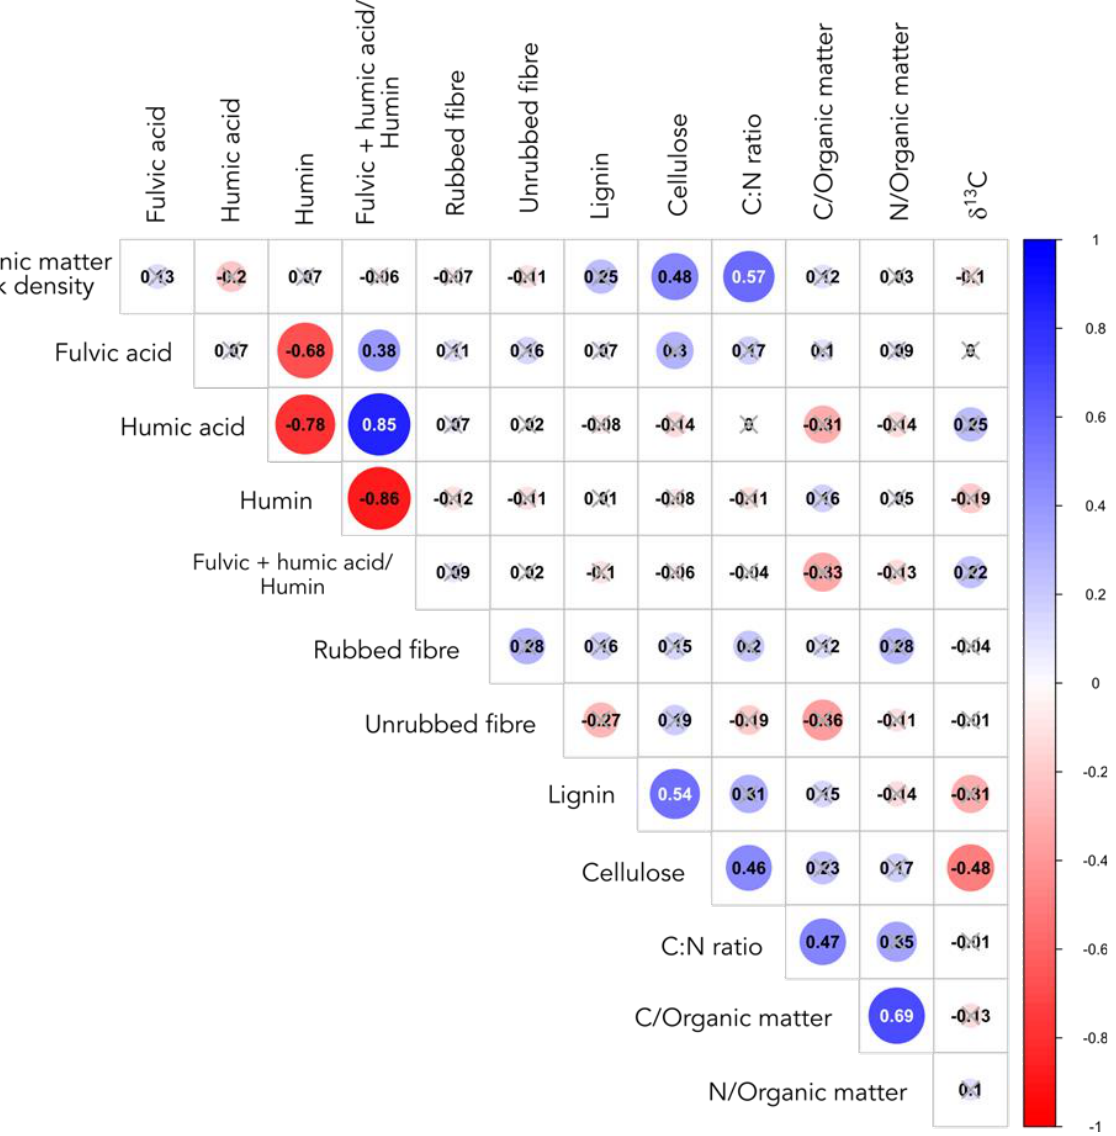
Figure 3. Correlation matrix between soil and organic matter attributes from the studied peatlands. Non- significant correlations are marked ‘ ×